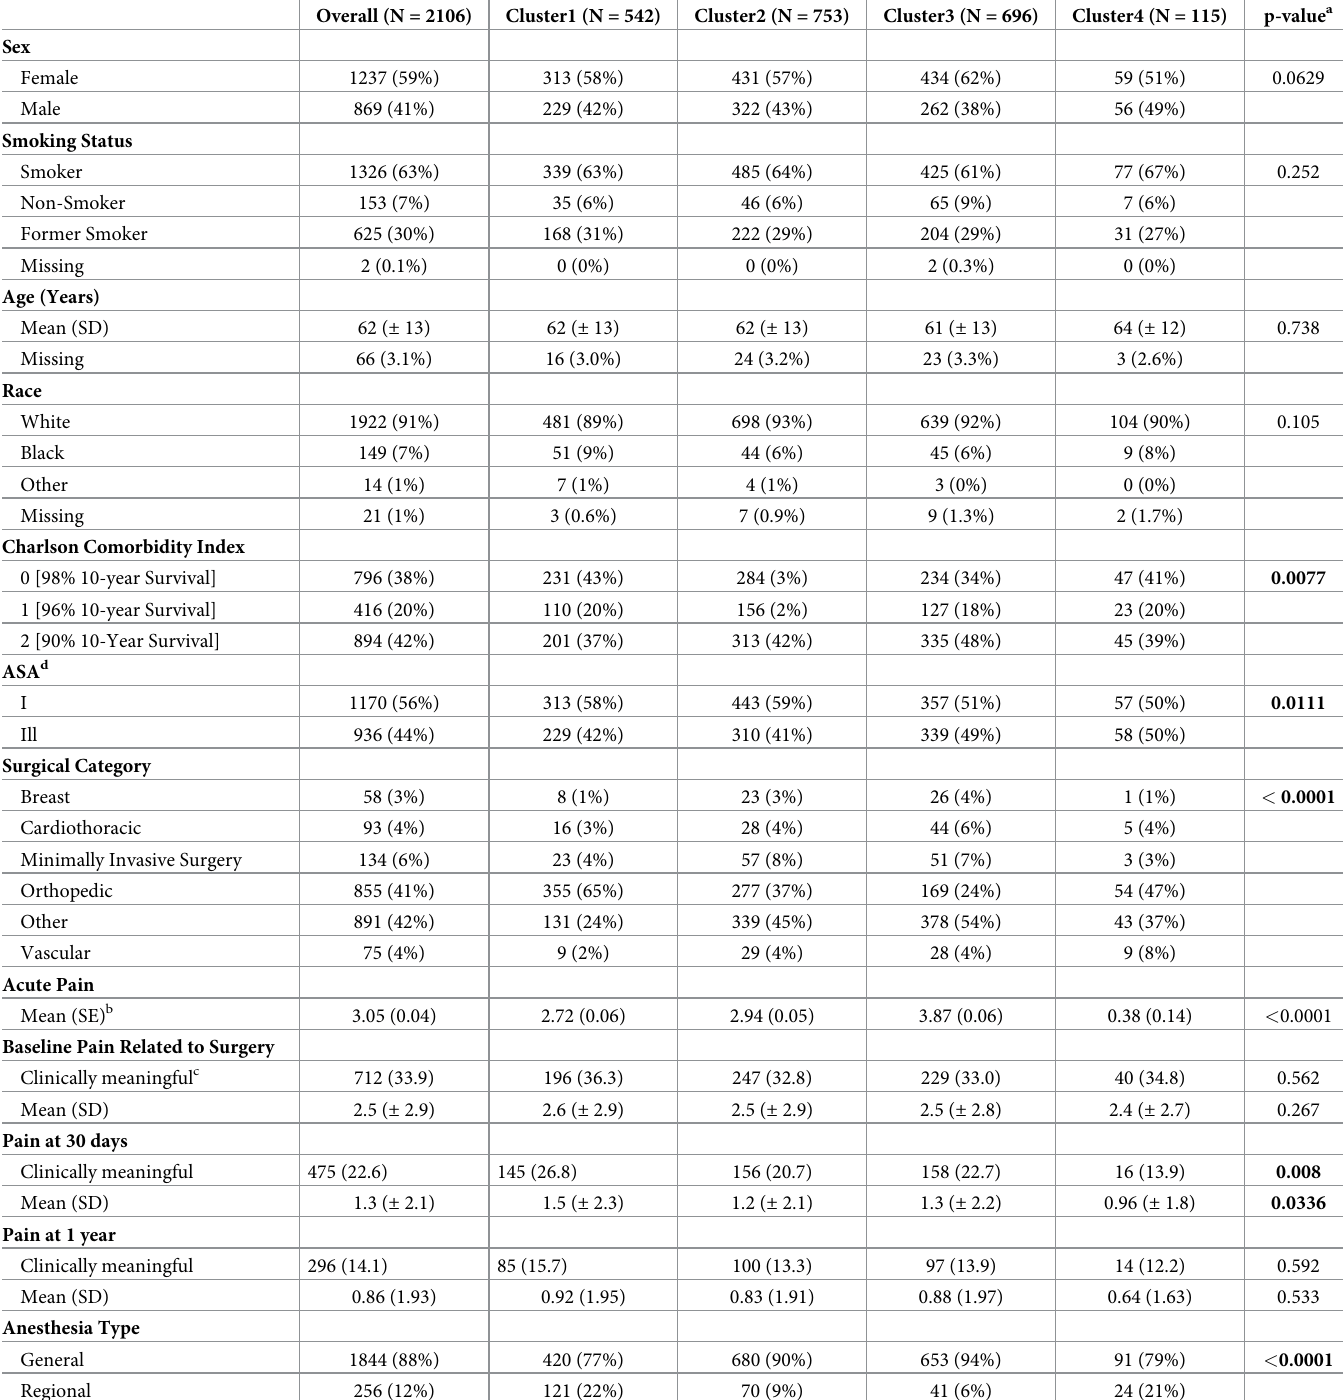
Table 1. Baseline characteristics of study subjects by trajectory